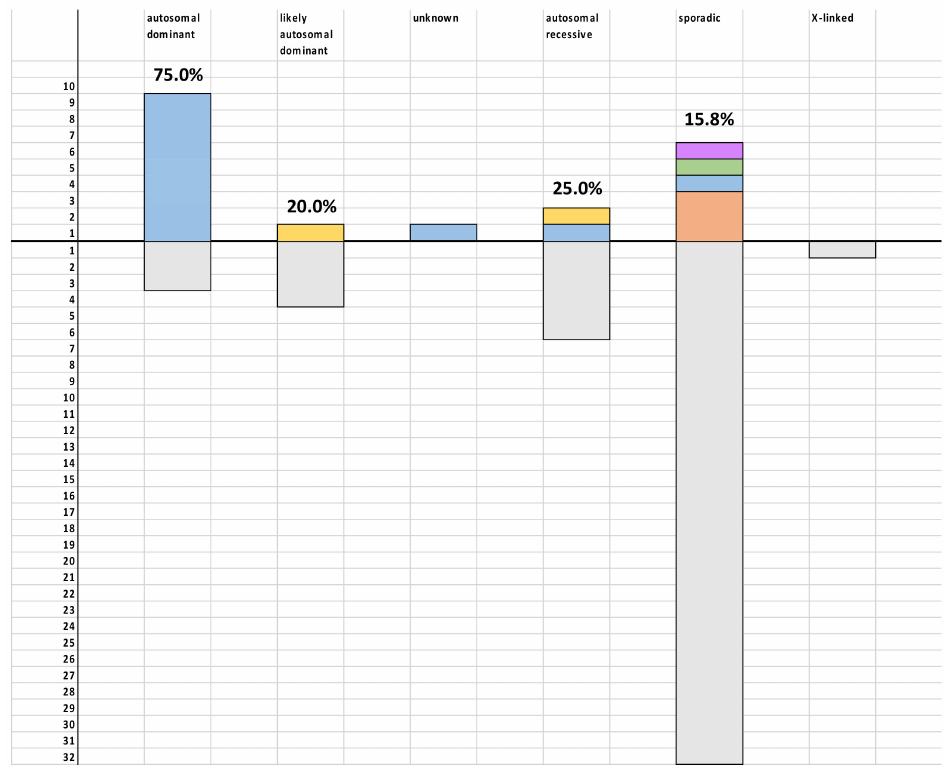
Figure 1. Percentage of HSP families with conclusive genetic findings based on the mode of in- heritance. Legend: X axis—mode of inheritance, Y axis—number of families. Genetically positive patients are shown above the X axis, and genetically negative below X axis. SPAST gene mutations are given in blue, SPG7 mutations in yellow, SPG11 in orange, KIF5A in green, and ZYFVE26 in violet. Percentage refers to percentage of patients with conclusive genetic findings among those with certain clinically defined mode of